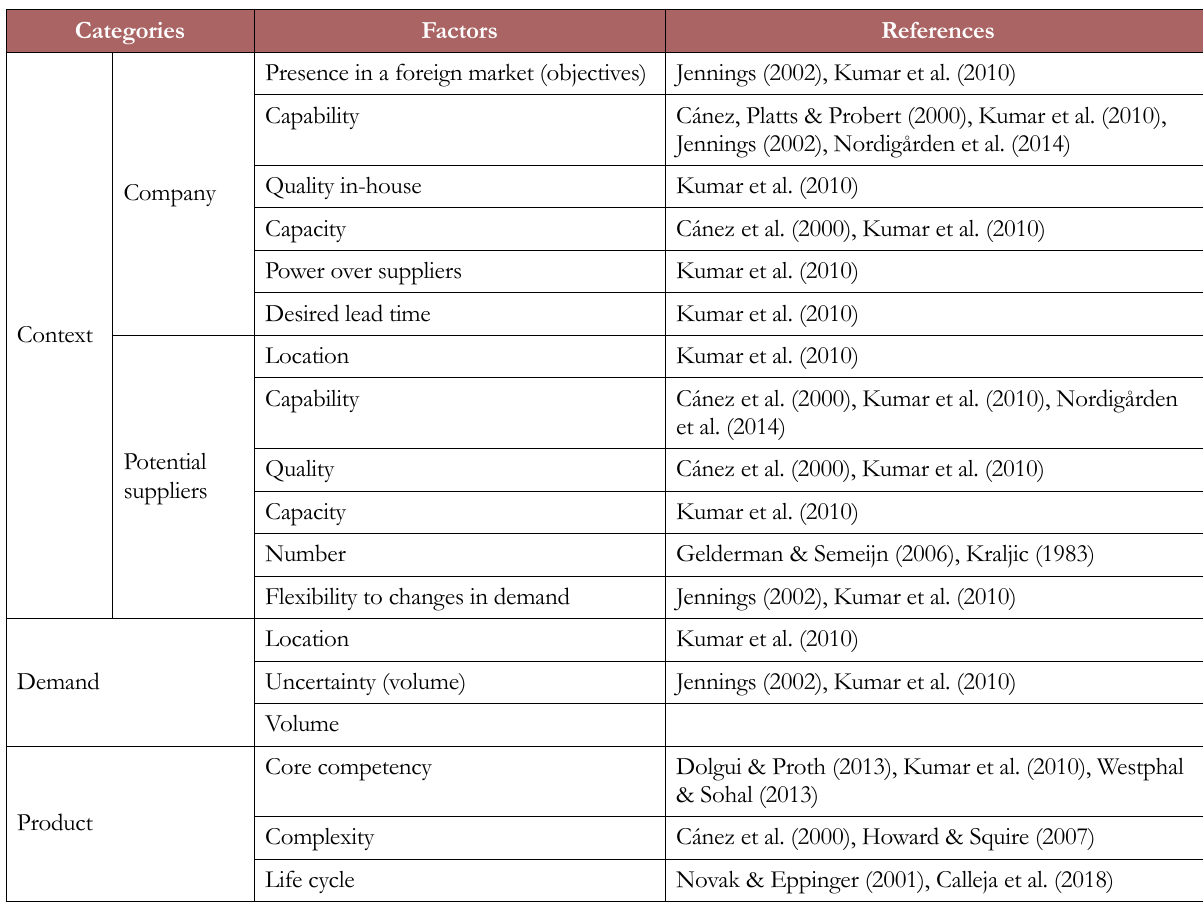
Table 2. Main factors when considering the sourcing strategy for an item